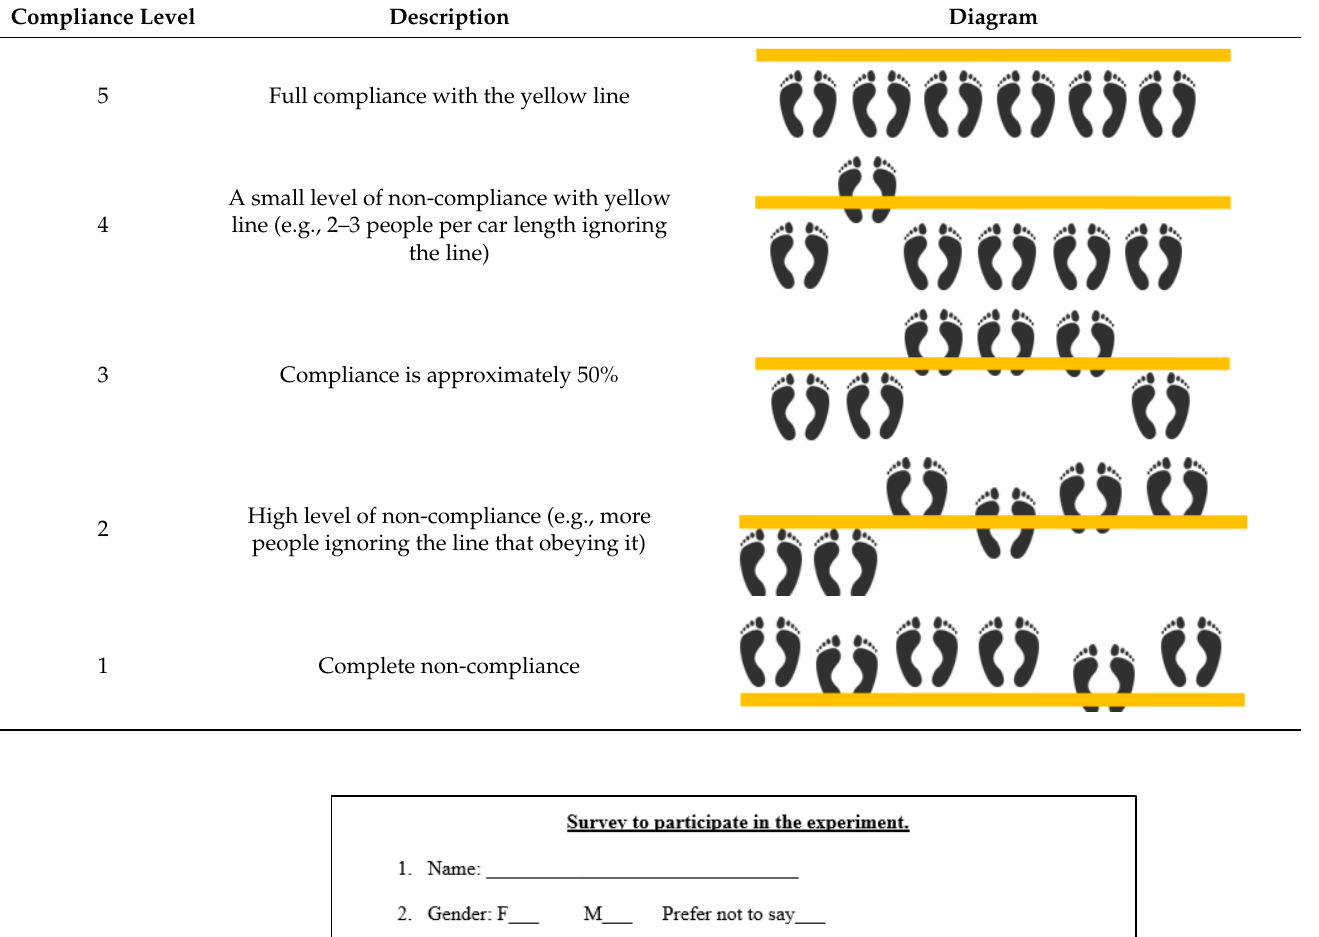
based on the position of passengers; however, passengers keep moving so the evaluation process was based on the instant of time when the approach of the train was announced. Table 2. Level of compliance using the experimental evaluation method to detect when passengers Table 2. Level of compliance using the experimental evaluation method to detect when passengers Table 2. Level of compliance using the experimental evaluation method to detect when passengers Table 2. Level of compliance using the experimental evaluation method to detect when passengers Table 2. Level of compliance using the experimental evaluation method to detect when passengers were respecting the yellow safety line adapted from [16]. were respecting the yellow safety line adapted from [16]. were respecting the yellow safety line adapted from [16]. Table 2. Level of compliance using the experimental evaluation method to detect when passengers were respecting the yellow safety line adapted from [16]. were respecting the yellow safety line adapted from [16]. were respecting the yellow safety line adapted from [16].